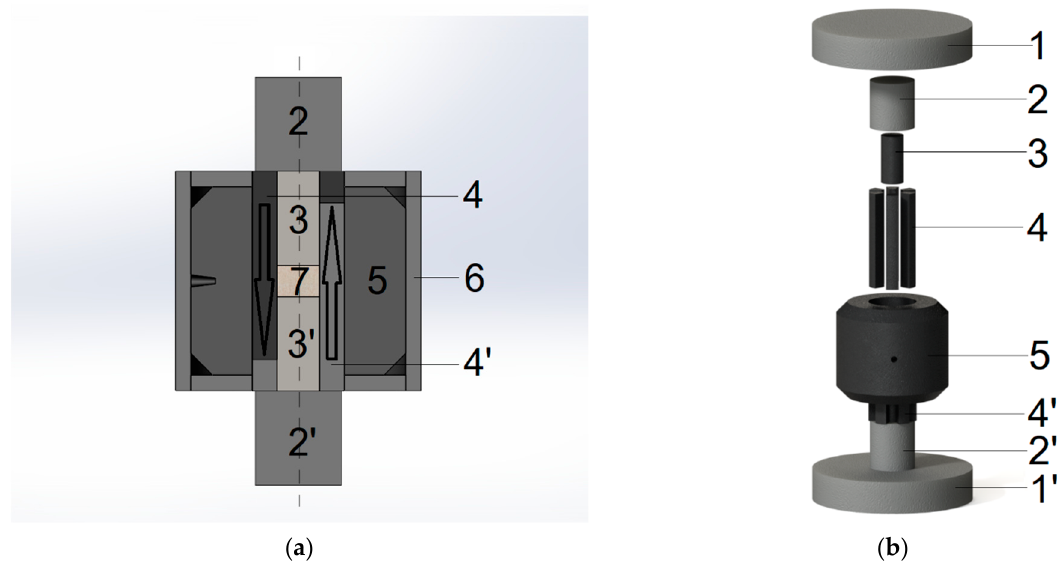
Figure 1. Schematic representation ( a ); the appearance of the collector mold: 1, 1’, 2, 2’—graphite spacers; 3 and 3’—punches; 4 and 4’—constituent parts of the forming elements; 5—matrix; 6—graphite insulation; 7—powder. ( b ) The arrows indicate the direction of movement of forming elements.